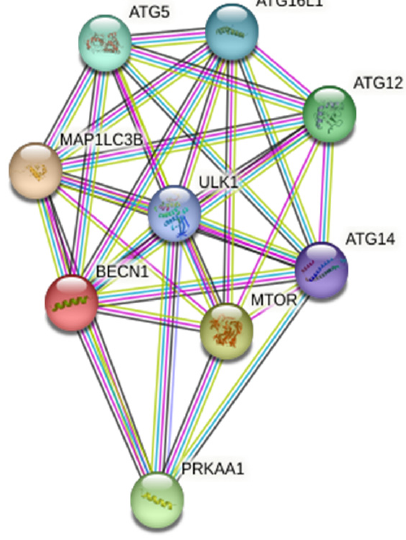
Figure 1. Protein-protein interactions between proteins associated with autophagy (https://string- db.org/; accessed on 27 January 2023). The edges colored purple reflect experimentally proven relationships, blue—relationships, information about which is obtained from supervised databases. Green edges reflect the neighborhood in the genome, blue—the joint occurrence, red—the fusion of genes. Light green ribs mean a joint mention of these proteins in Pub-Med Abstracts, black—co-expression, and light blue—homology. Note: Interactions: